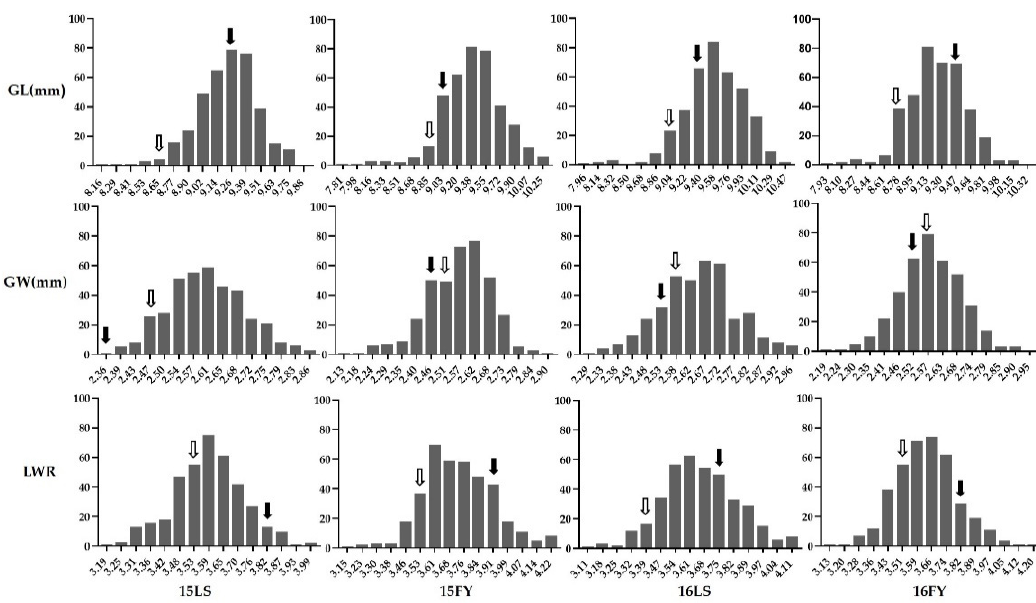
Figure 1. The distribution of grain shape related traits in RISLs in four environments. The hollow arrow represents Nei2B, and the solid arrow represents R8006. GL, grain length. GW, grain length. LWR, length-width ratio.